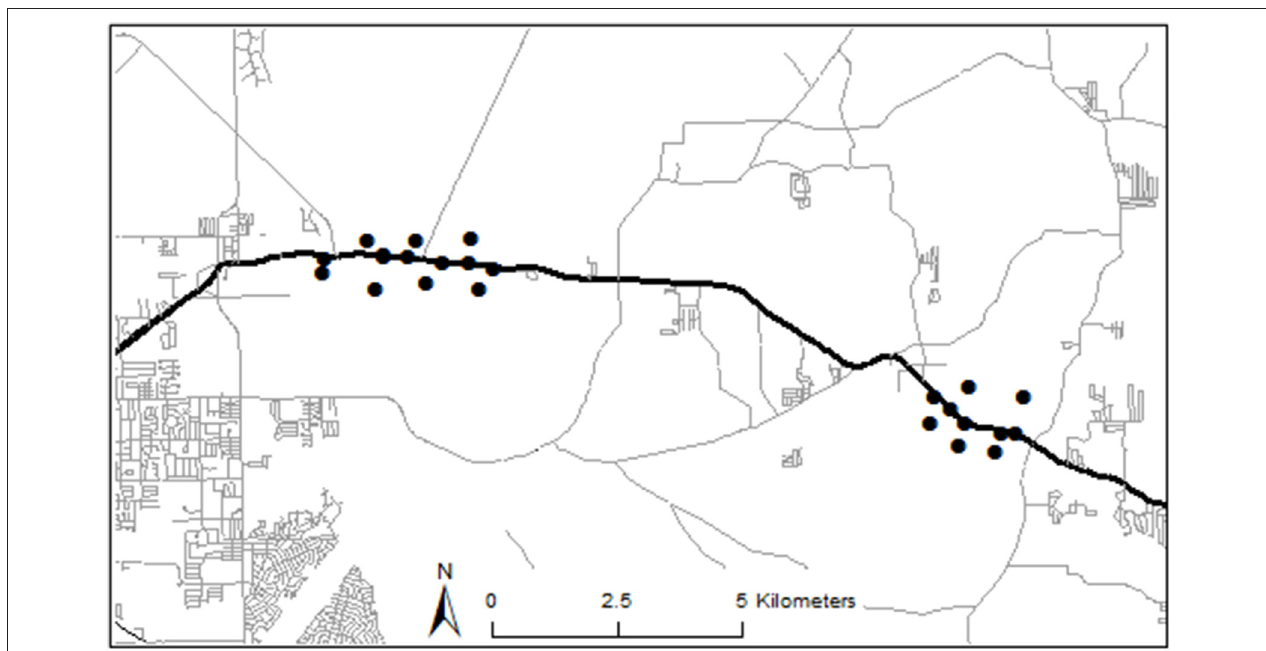
FIGURE 1 | Map of trap locations and nearby roads. State Road 40 is denoted by the thick black east-west line. Trap locations are denoted by black dots. Two dots indicating roadside traps in the western section appear to overlap on map, but they were separated by ≈ 100m and were on different sides of the road. All paved roads within 5 km of study locations have annual average daily traffic volume (AADT) < 2,000 cars/day. Unpaved roads and trails were omitted from this map for